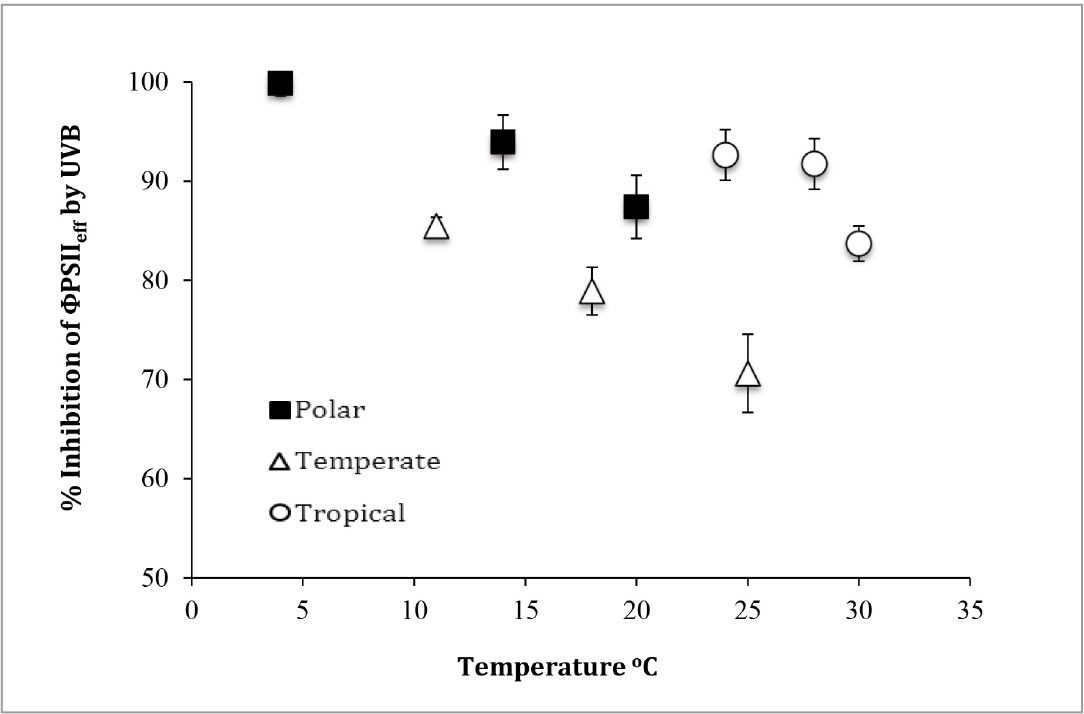
Fig 4. Inhibition of Φ PSII eff of polar, temperate and tropical Chlorella after 60 min exposure to PAR + UV-A + UV-B. Vertical bars denote standard deviations from triplicate